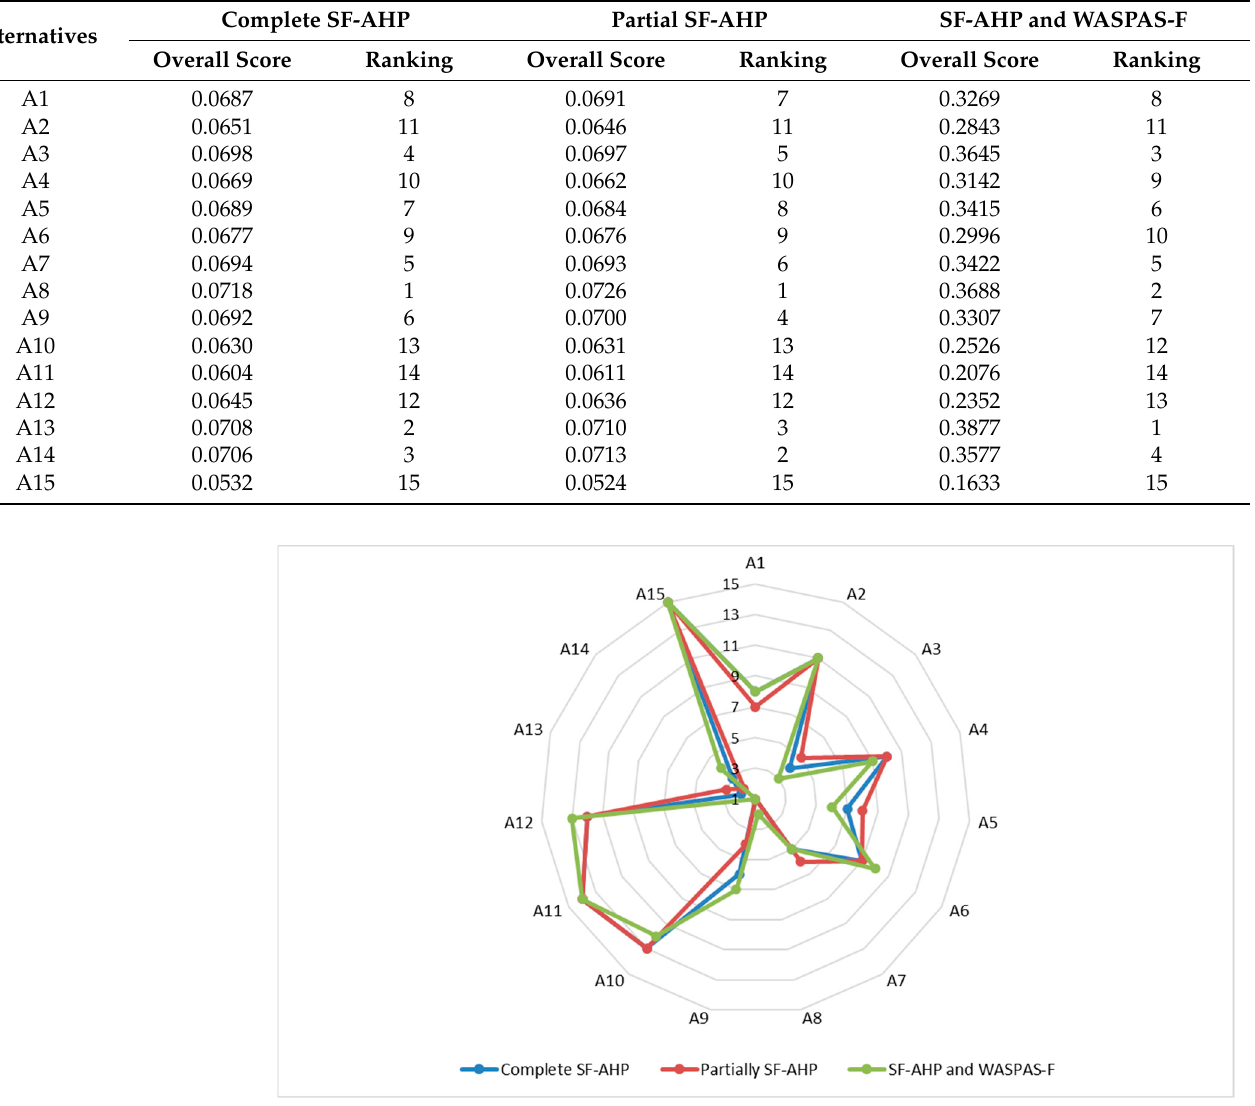
Figure 5. Radar plot for comparative analysis of different models.